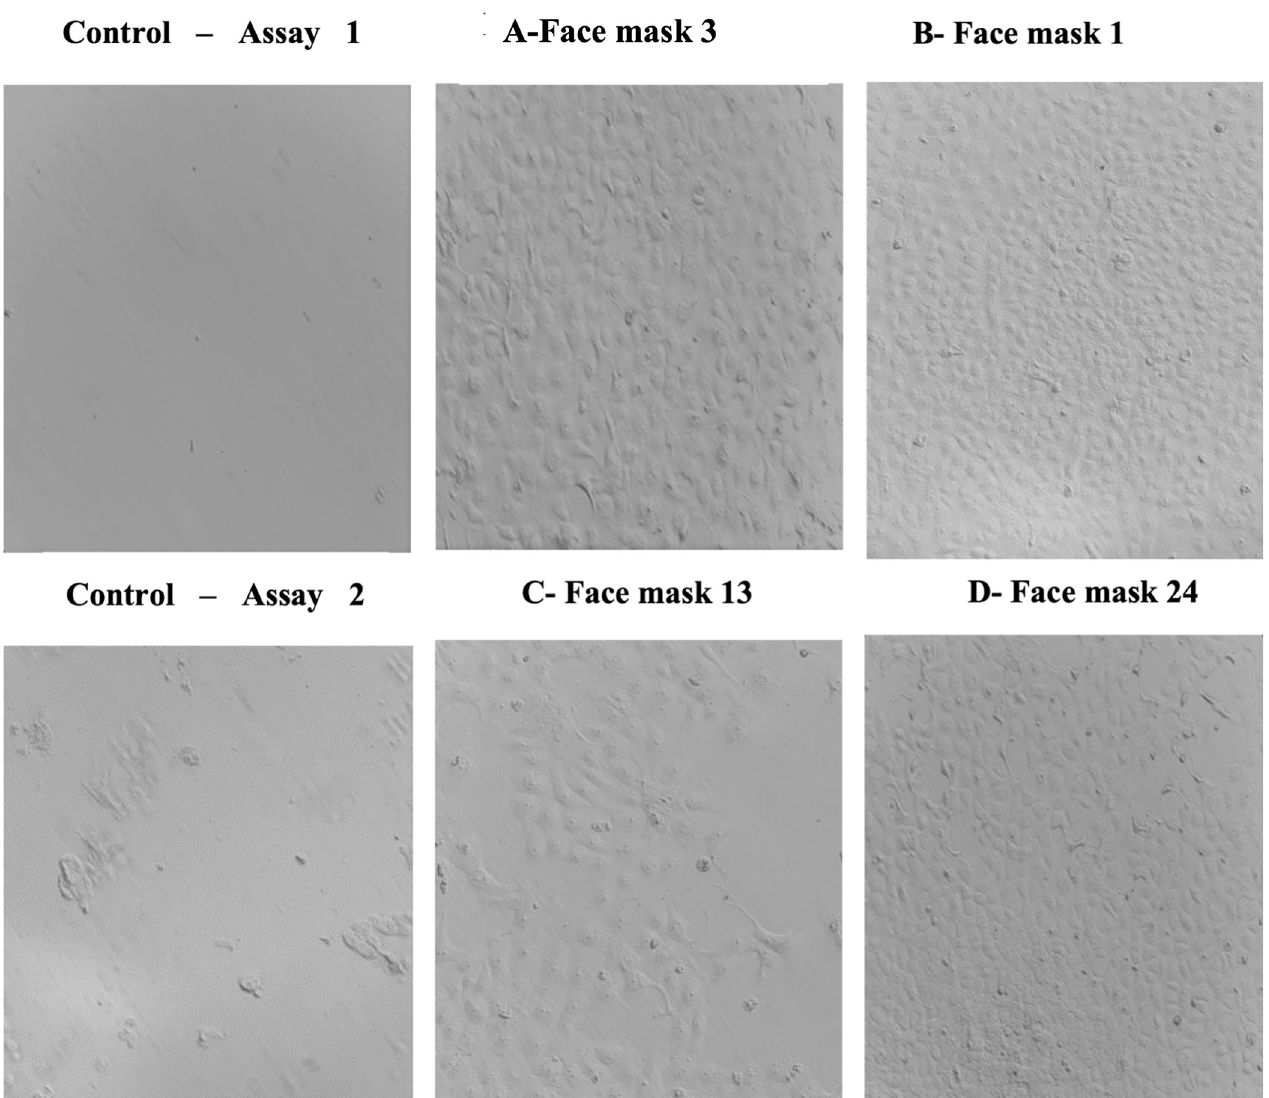
Fig 1. Images of VERO cells monolayer (x 20) after 48 h of incubation with patient´s face masks treated with different ozone concentrations and exposure times in the preliminary phase (assays 1 and 2). A and B show no cytopathic effect after cell culture incubation of face mask 3 treated with ozone at A- 2,000 ppm for 10 min and face mask 1 treated at B- 10,000 ppm for 10 min. Image C- shows the partial lysis of the cell monolayer observed when incubation with face mask 13 treated at ozone concentrations of 2,000 ppm for 5 min. Image D- shows the effect of exposure to face mask 24 treated at 4,000 ppm for 2 min where cells are alive suggesting no viability of SARS-CoV-2 under this condition. The positive control consisted of VERO cells infected with human coronavirus 229E ATCC 1 VR-740 ™ strain. Images are representative of experiments performed in triplicate.